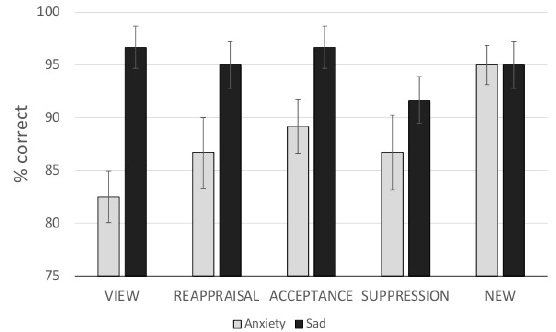
Figure 5. Recognition test: Percentage mean and standard error of correct decisions concerning the familiarity (just seen in the experiment phase) for new pictures and pictures of the view, reappraisal, acceptance, and suppression condition.